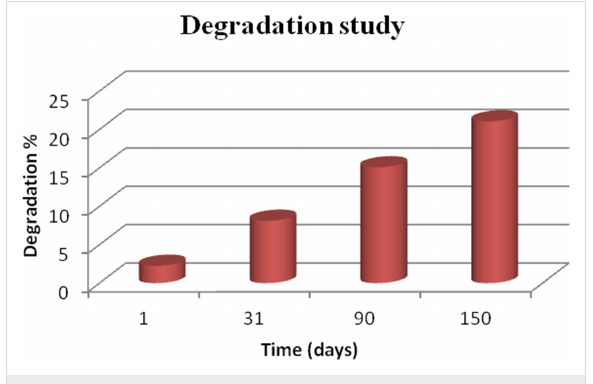
Figure 5: In vitro degradation of CA scaffolds loaded with dexametha- sone as function of the time.